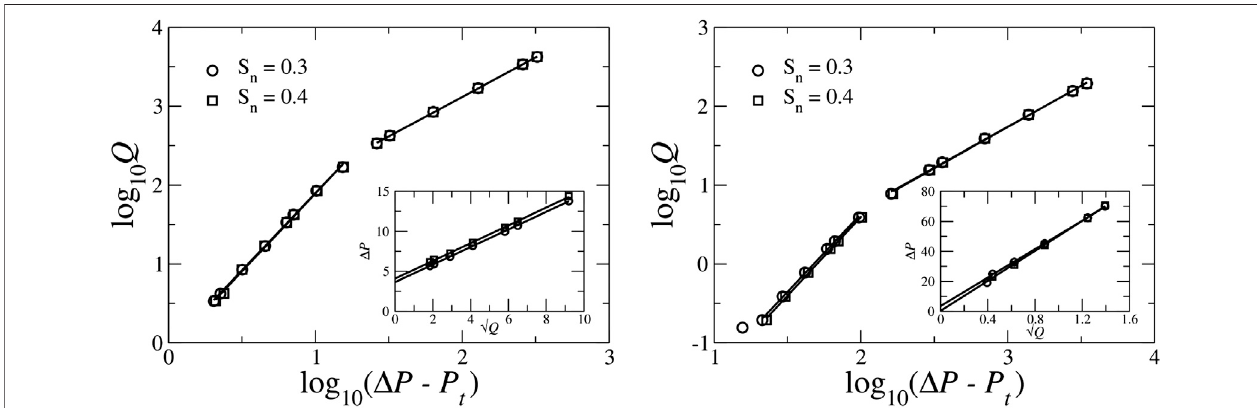
FIGURE 11 | Variation of the total volumetric fl ow rate Q (mm 3 / s) with the overall pressure drop Δ P (kPa) in the steady state for square and Berea networks. In the (cid:14)(cid:14) √ inset, Δ P isplottedagainst Q forthelowCaregimewheretheinterceptsatthe y -axiscorrespondtothevaluesofthresholdpressures( P t ).For2D,we fi nd P t (cid:1) 3 . 65kPa and4.09 kPafor S n (cid:1) 0 . 3and0.4respectively.FortheBereanetworkin3D,we fi nd P t (cid:1) 3 . 54kPaand0.32kPafor S n (cid:1) 0 . 3and0.4respectively.Usingthesevalues,we plot log 10 Q vs. log 10 ( Δ P − P t ) which shows two distinct regimes at low and high pressures. For the linear regime, the slopes are obtained as 0 . 99 ± 0 . 01 and 1 . 00 ± 0 . 01 for 2D and 1 . 03 ± 0 . 01 and 1 . 04 ± 0 . 01 for 3D for the two saturations respectively. For the quadratic regime, the slopes are obtained as 1 . 96 ± 0 . 02